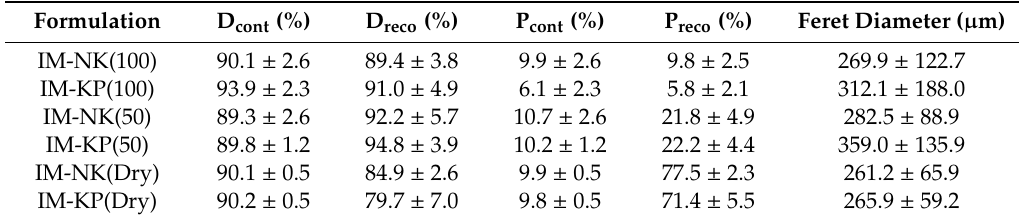
Table 3. Drug Content Ratio, Drug Recovery, PVA Content Ratio, PVA Recovery, and Feret Diameter of IM